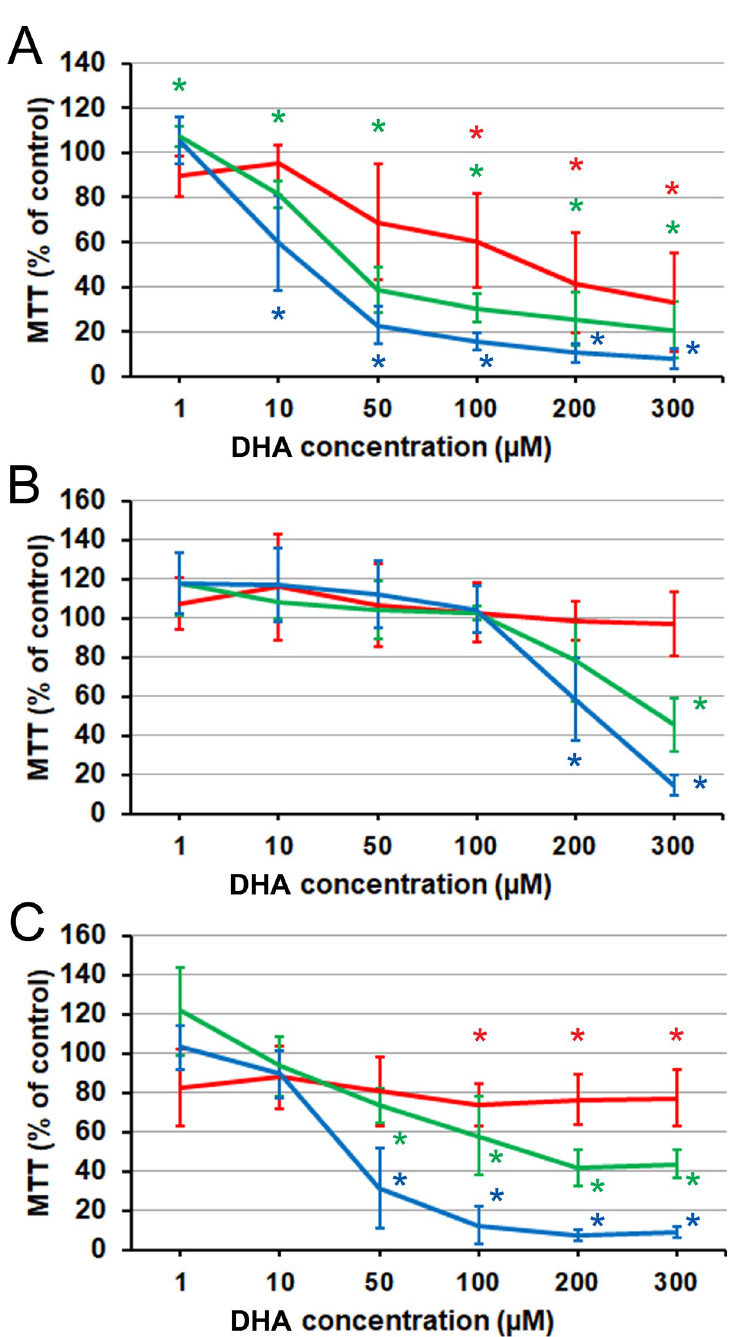
Fig 3. Effect of DHA on prostate cancer cells proliferation and viability as measured by MTT assay. (A) PC3 cells. (B) LNCaP cells. (C) C4-2 cells. Red line: 24 h. Green line: 48 h. Blue line: 72 h. Error bars: standard deviation. Asterisk: difference from the control is significant on the significance level 0.05, corrected for multiple comparisons. Each data point is the average of n = 9 cell cultures.